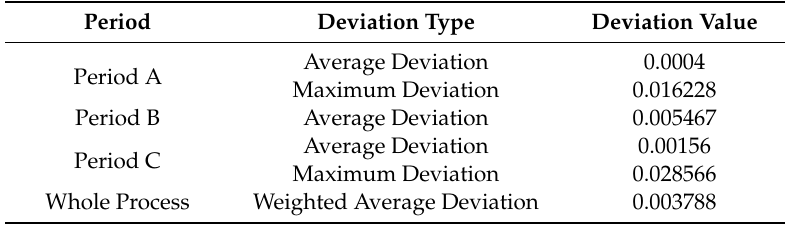
Table 5. Model evaluation of active current under large disturbance of grid